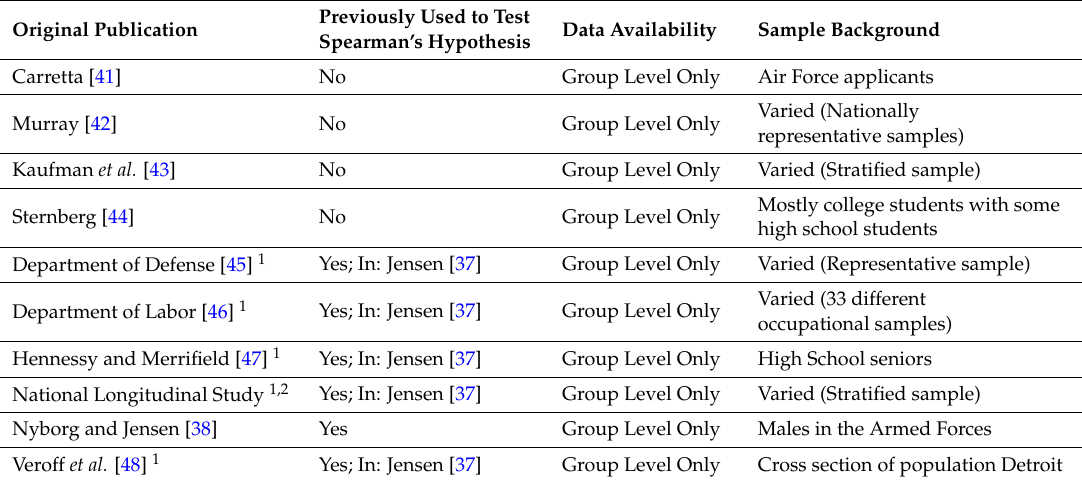
Table 1. Information on Studies Used in Current